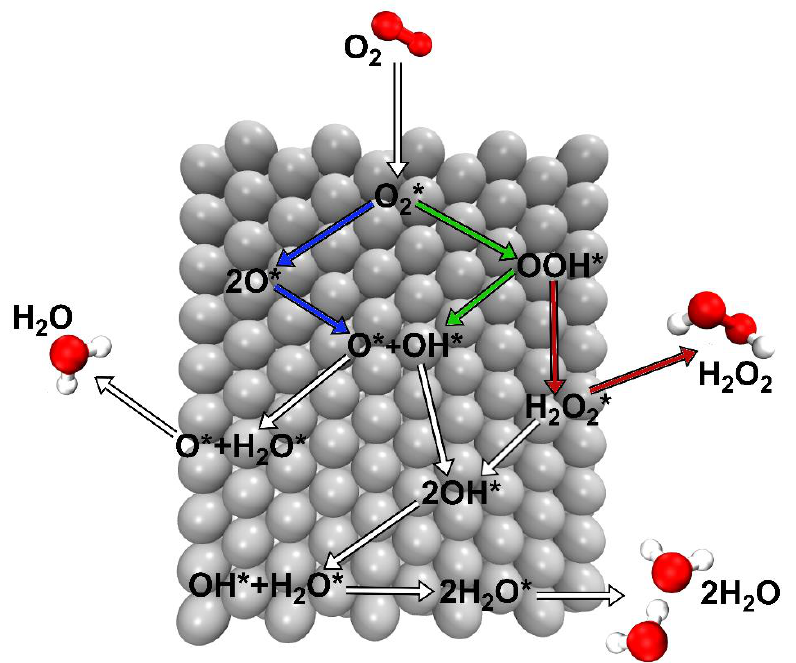
Figure 10. Sketch of proposed ORR mechanisms onto platinum as catalyst and relative products. The so-called associative and dissociative mechanisms are indicated by green and blue arrows, respectively. The formation of undesired hydrogen peroxide H 2 O 2 is shown with red arrows. White arrows indicate the common steps.